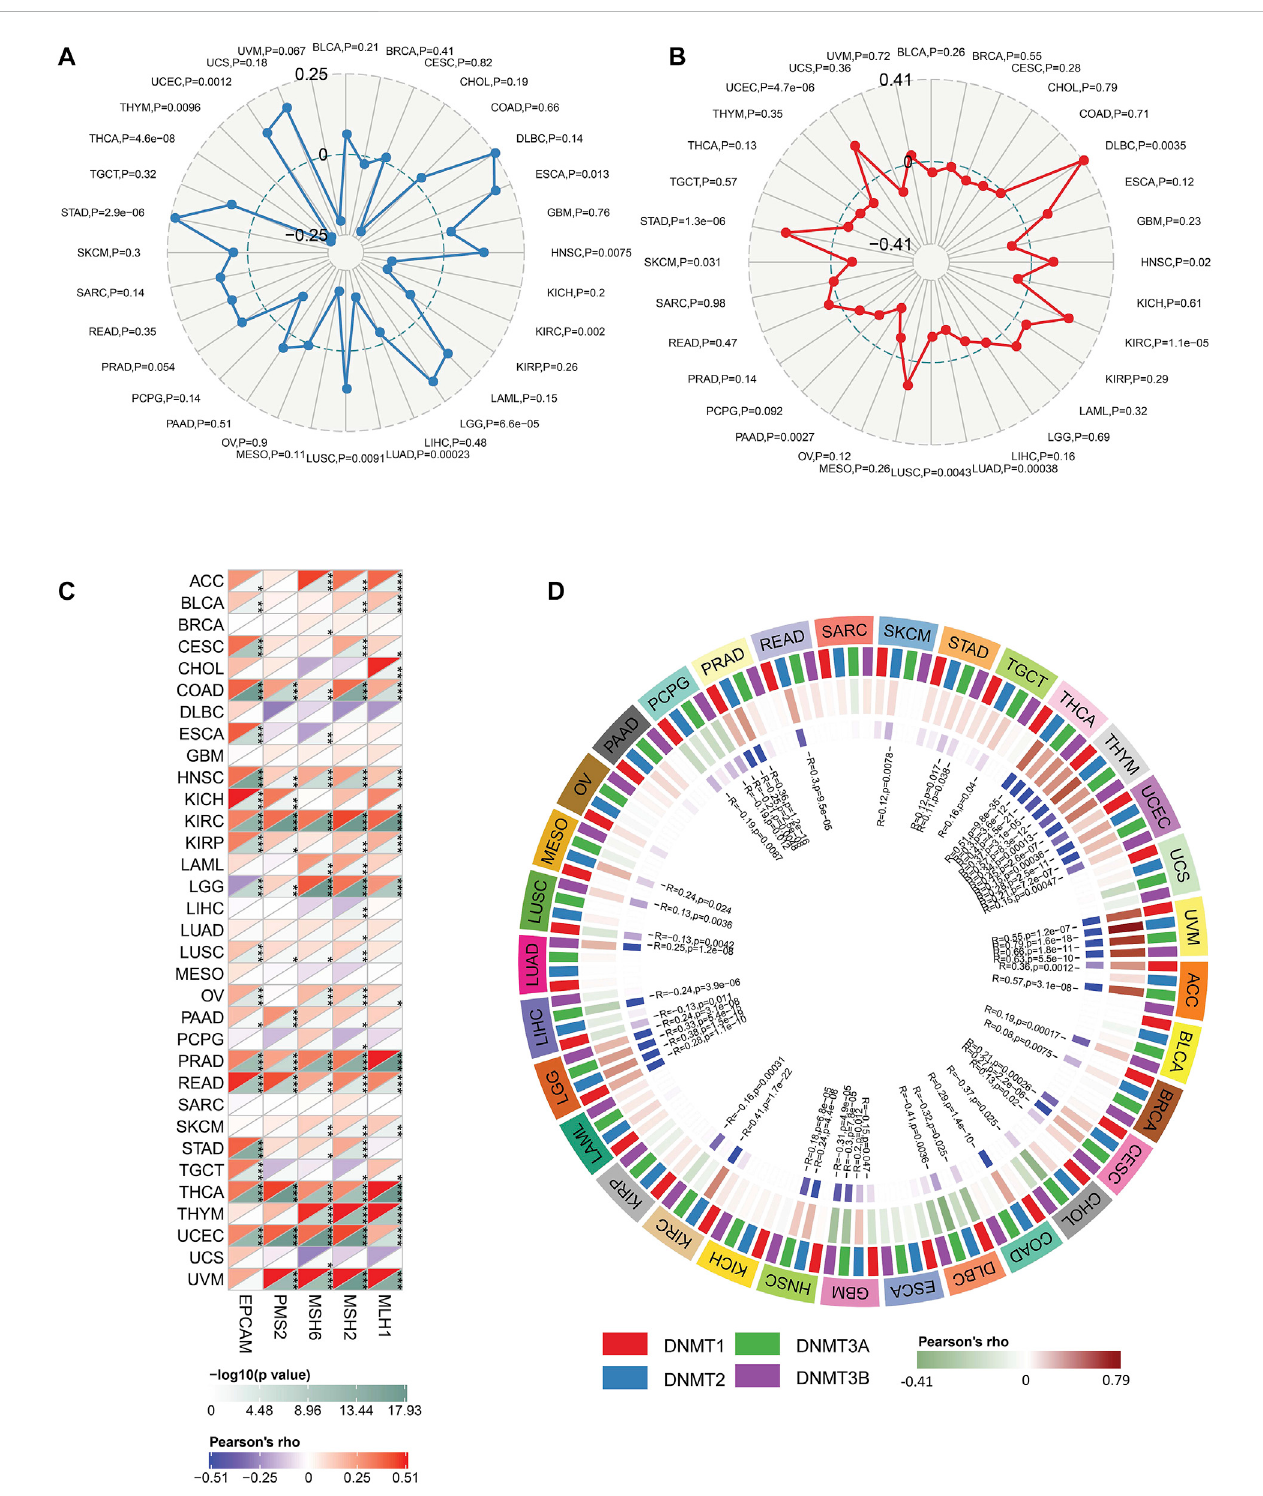
FIGURE 6 The correlation between FDX1 and tumor Mutation Burden (TMB), microsatellite instability (MSI), mismatch repair (MMR), and DNA methyltransferase (DNMT). (A) The correlation between FDX1 expression and TMB. (B) The correlation between FDX1 expression and MSI. (C) The correlation between FDX1expressionandMMRgenes(MLH1,MSH2,MSH6,andEpCAM). (D) ThecorrelationbetweenFDX1expressionandDNMT(DNMT1,DNMT2,DNMT3A,and DNMT3B). (TMB and MSI were analyzed by Spearman coef fi cient, other correlation analysis was shown by Pearson coef fi cient, p < 0.05 was considered signi fi cant, * p < 0.05, ** p < 0.01, *** p <